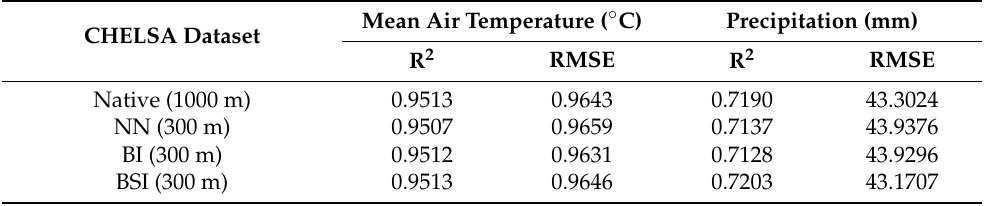
Table A2. The accuracy assessment of downscaling methods of CHELSA mean air temperature and precipitation data compared to ground truth data from DHMZ stations.